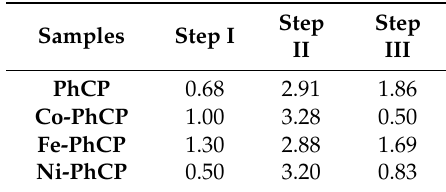
Table 3. Reaction order obtained by Friedman method for PhCP and all metal forms (Co-PhCP, Fe-PhCP, and